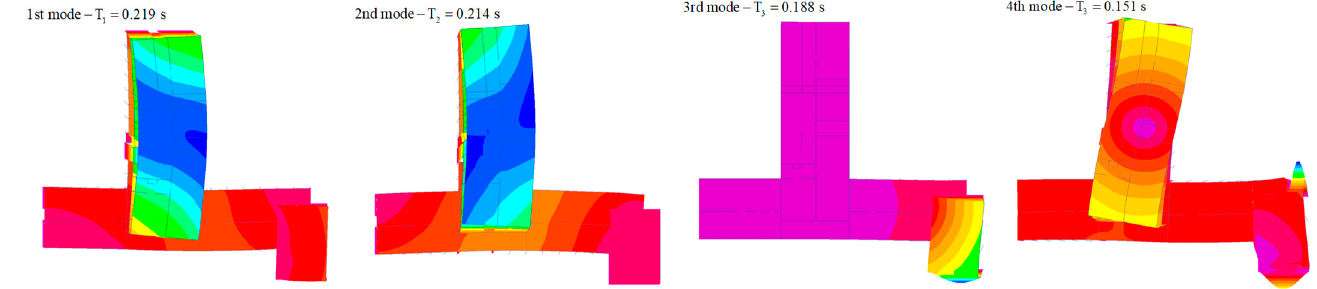
Figure 23. Eigenmodes and corresponding periods values for cracked sections of the retro fi tt ed